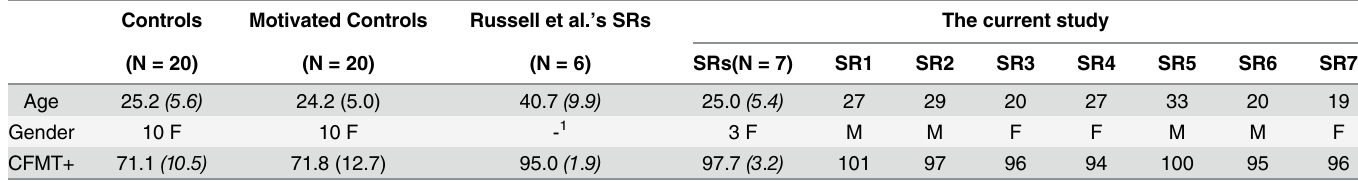
Table 1. Demographical information and CFMT+ scores for the SR participants used in this study and those described by Russell, Chatterjee, and Nakayama [22]. Standard deviations are in parentheses. Controls